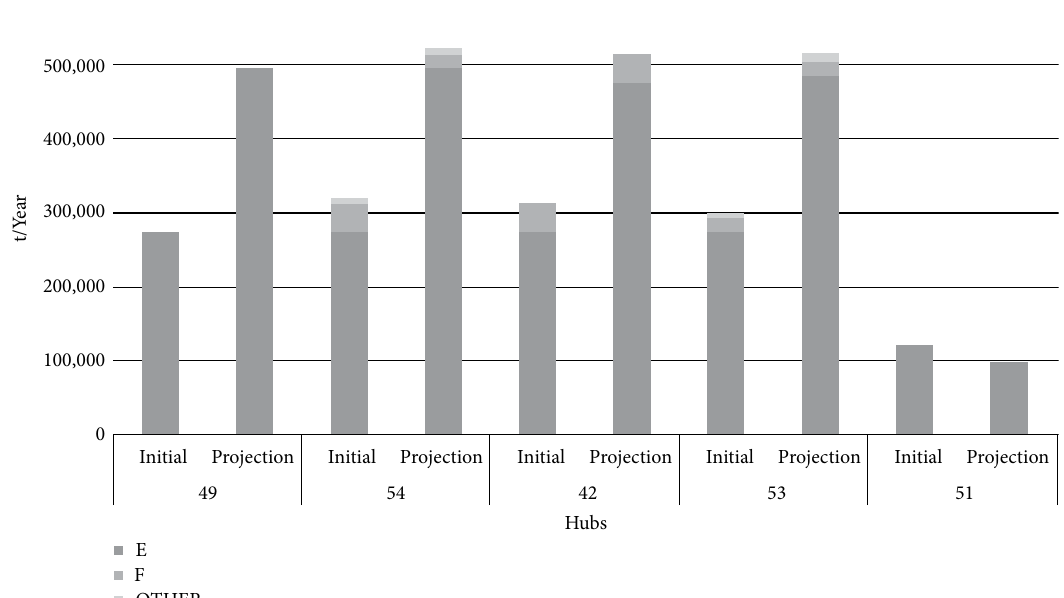
Figure 3: Products attended by each